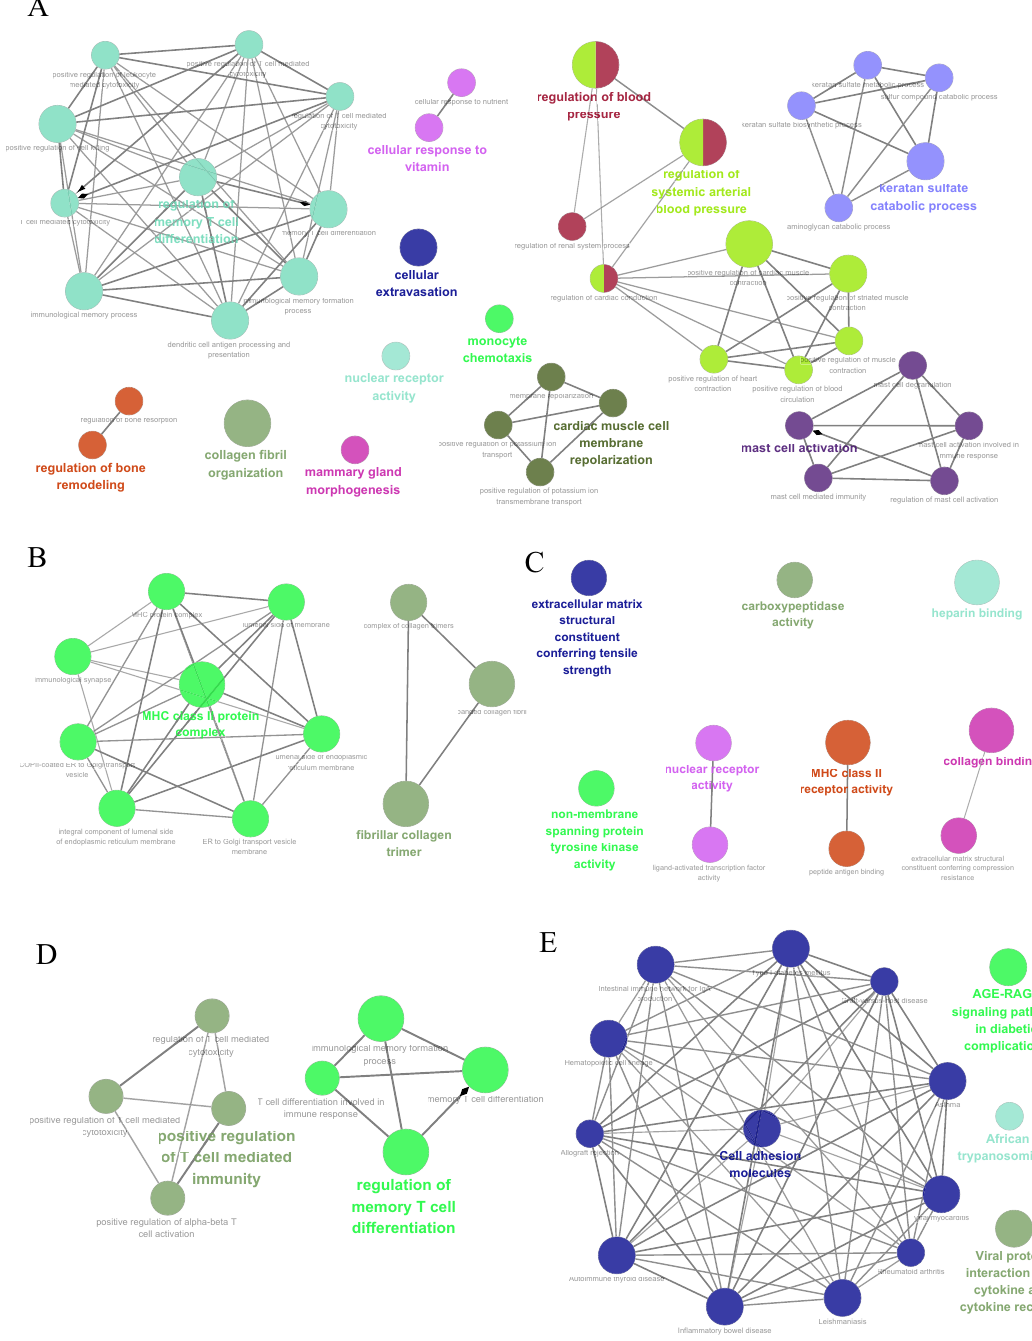
Figure 3. Enrichment analysis for DEGs using ClueGO. ( A ) Biological processes related enrichment; ( B ) cellular component related enrichment; ( C ) molecular function related enrichment; ( D ) immune system processes related enrichment; ( E ) KEGG enrichment. DEGs: differentially expressed genes; KEGG: Kyoto Encyclopedia of Genes and Genomes. P -value < 0.05 was set to show the terms and pathways with the medium network connectivity (kappa score of 0.4). The leading group terms were displayed based on the highest significance. Each group is presented by the label with the most significant term or pathway, which was circled by the dotted circle. The node size represents the term or pathway enrichment